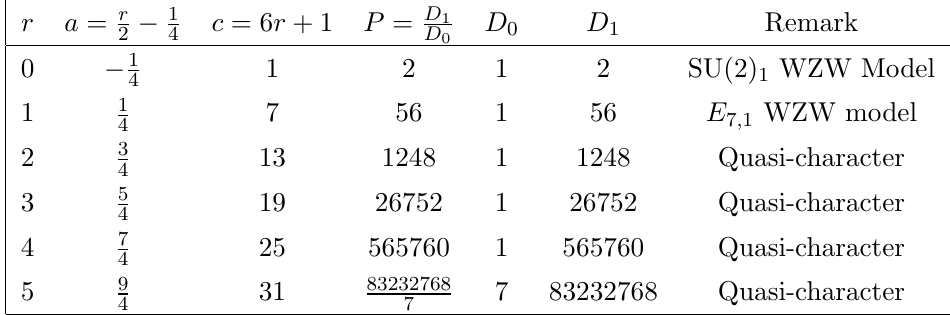
Table 4 . The A 1 series (Multiplicity M =